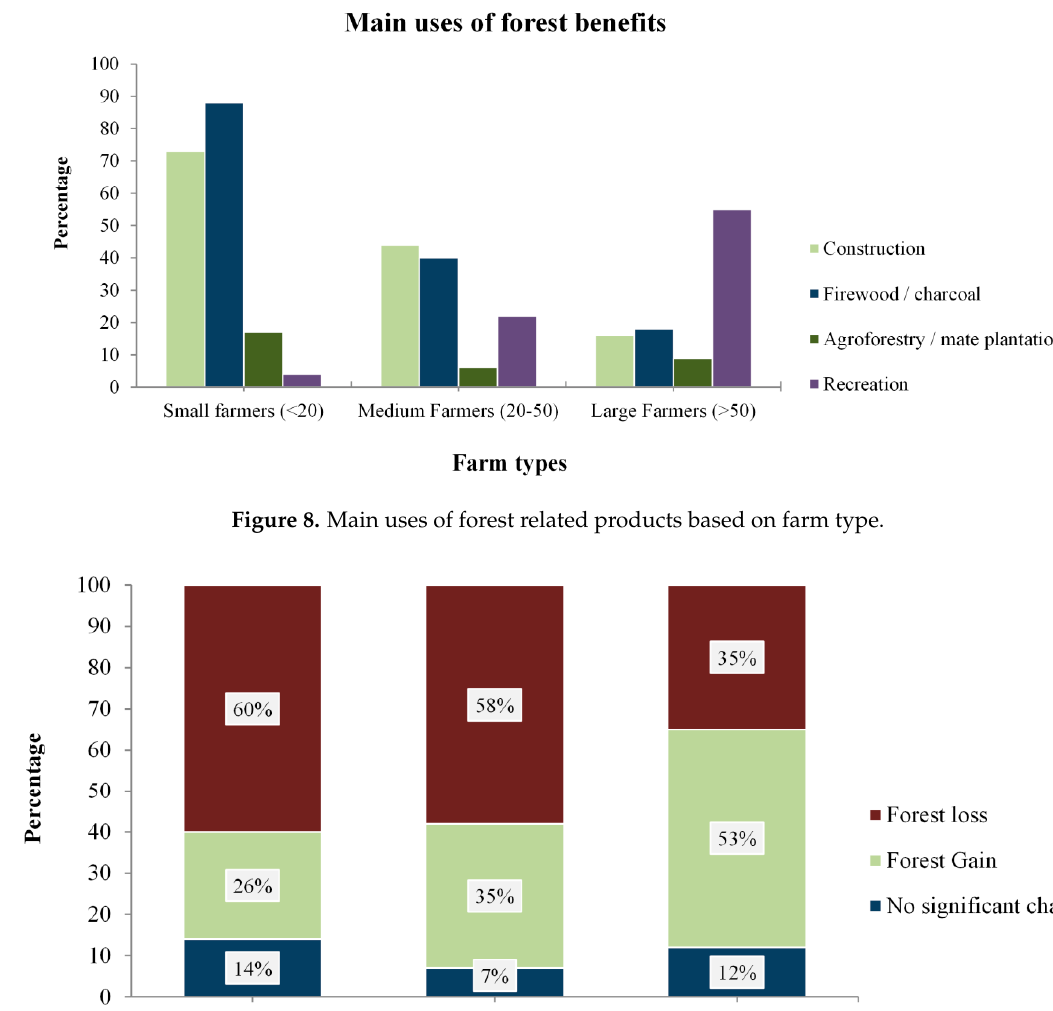
Figure 9. Dynamics of the forest cover based on the level of dependency.